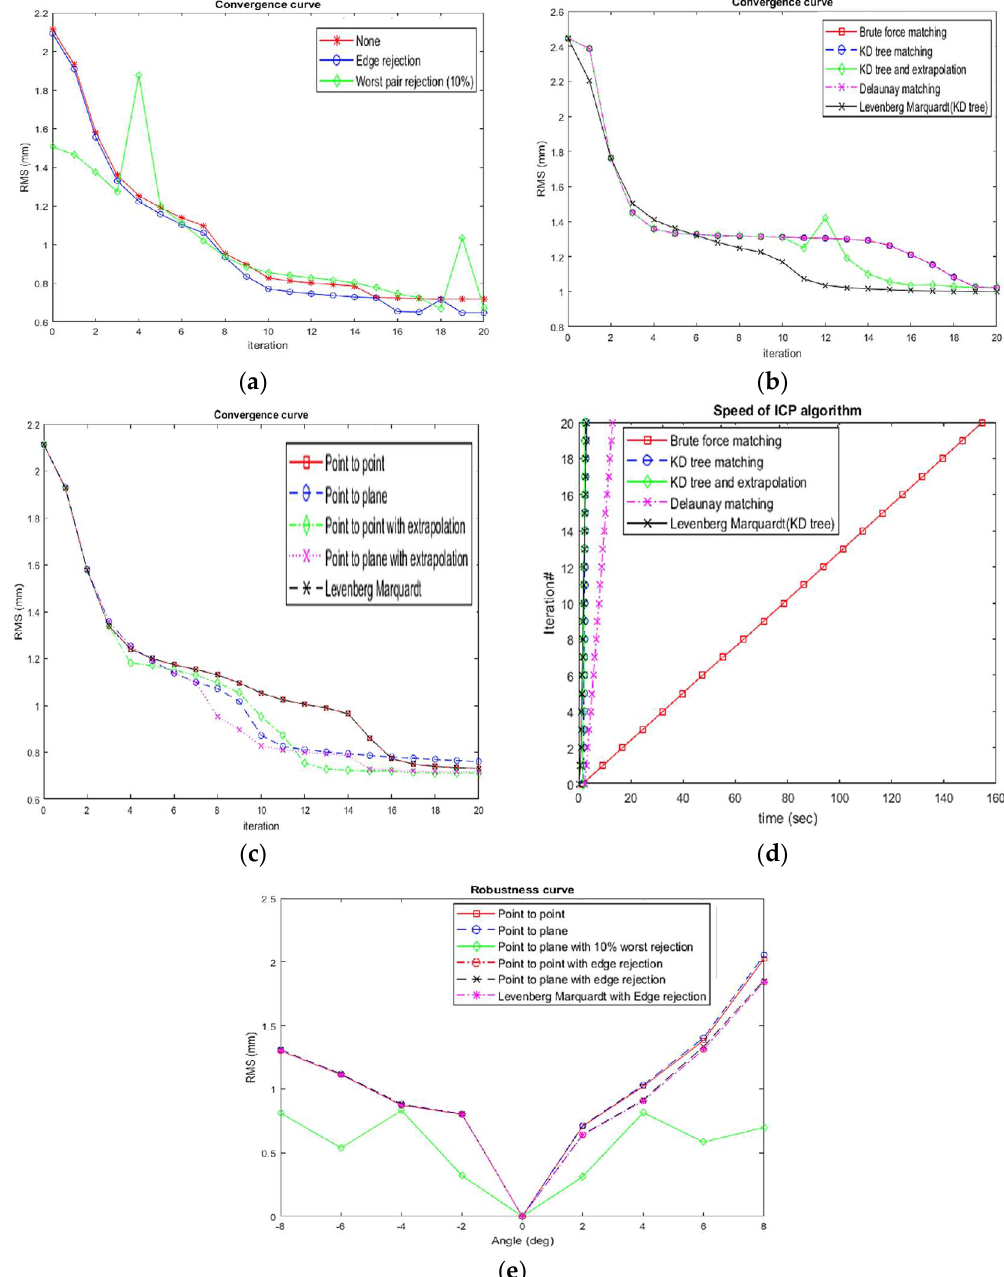
Figure 8. Characteristics of ICP to compare the proposed algorithm with the other variants, ( a – c ) the convergence behavior of the proposed algorithm and other variants for outlier removal, matching and error metrics respectively, and ( d , e ) speed and robustness of the proposed algorithm and other variants.